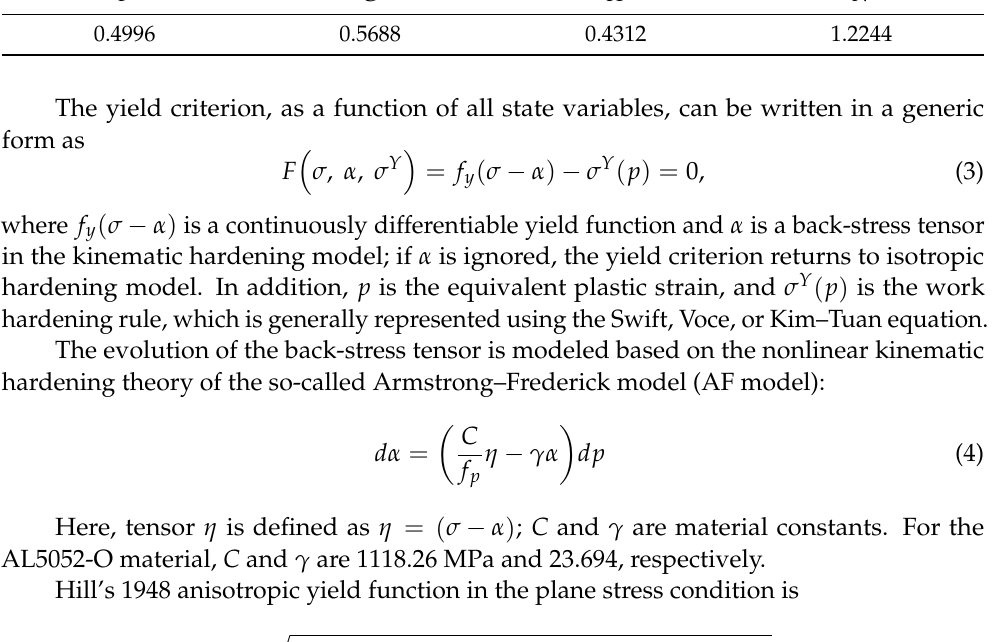
Yield Function Hill48